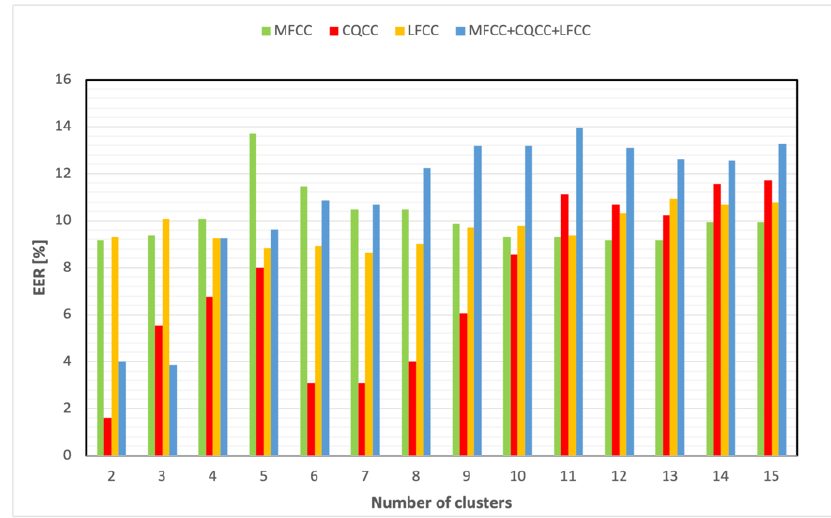
Figure 5. EER obtained with MFCC, QCC, LFCC, and concatenation together with respect to the number of clusters when using SVM on the ASVspoof 2017 version 2.0 benchmark dataset.